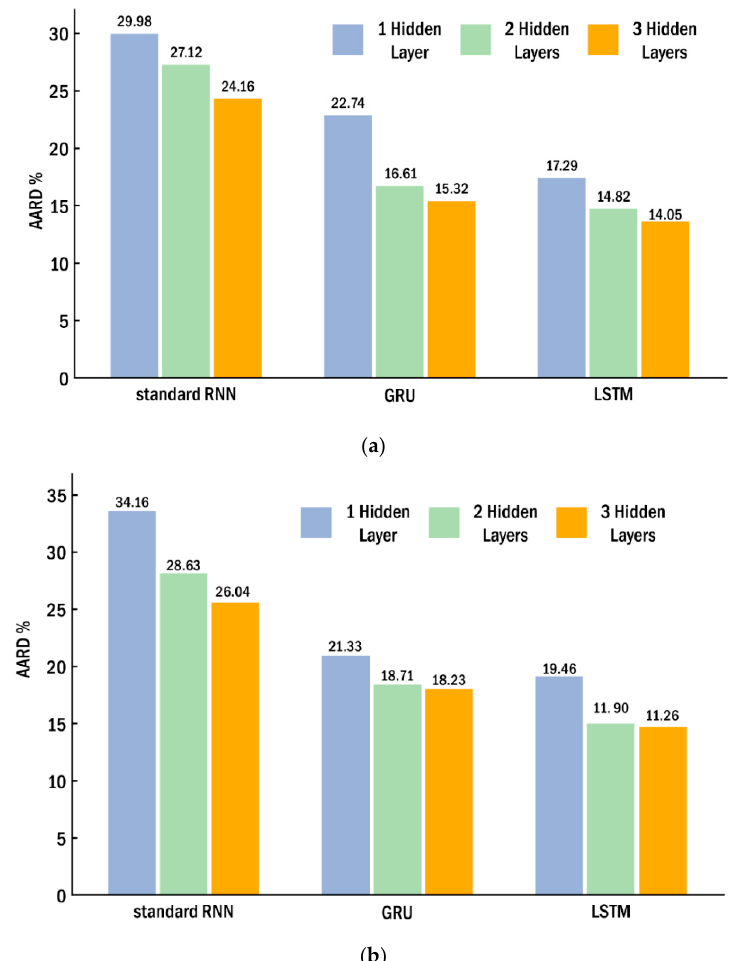
Figure 14. Comparison of average absolute relative deviation (AARD) results between standard Recurrent Neural Network (RNN), LSTM, Gated Recurrent Unit (GRU): ( a ) Comparison of AARD results between standard RNN, LSTM GRU in terms of pressure; ( b ) Comparison of AARD results between standard RNN, LSTM, GRU in terms of water saturation.